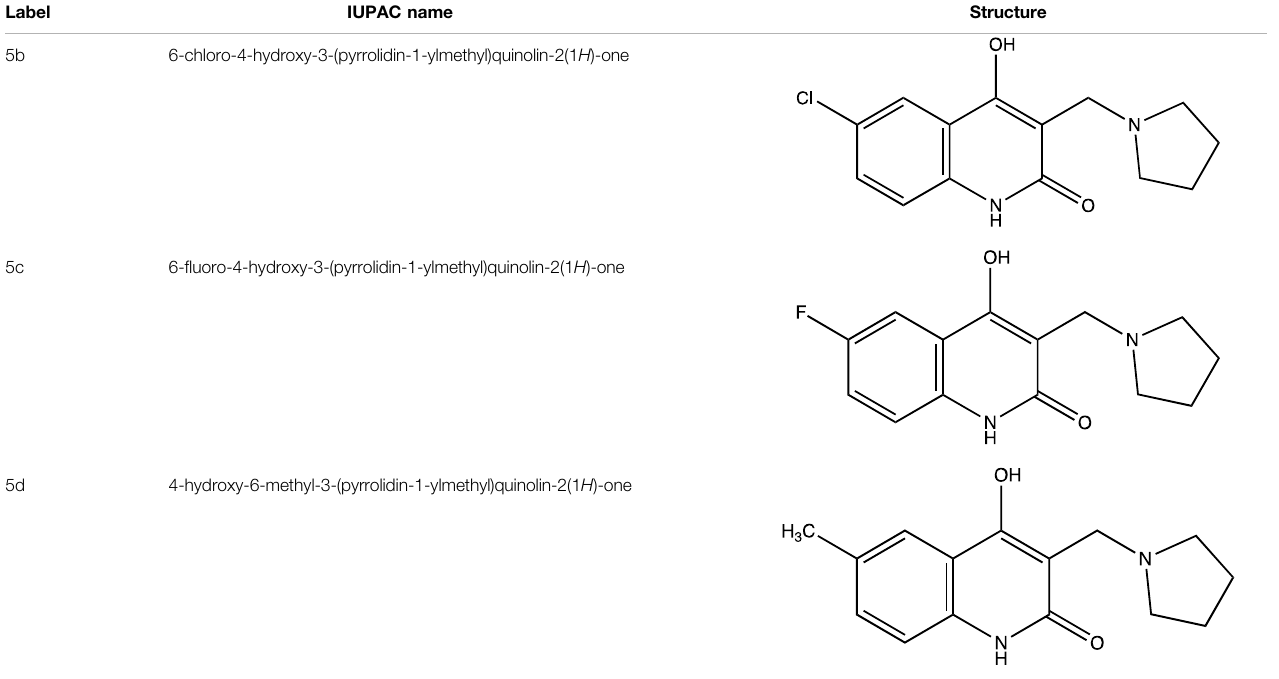
TABLE 2 | MolDock scores of synthesized compounds (3a-d, 4a-d, 5a-d).